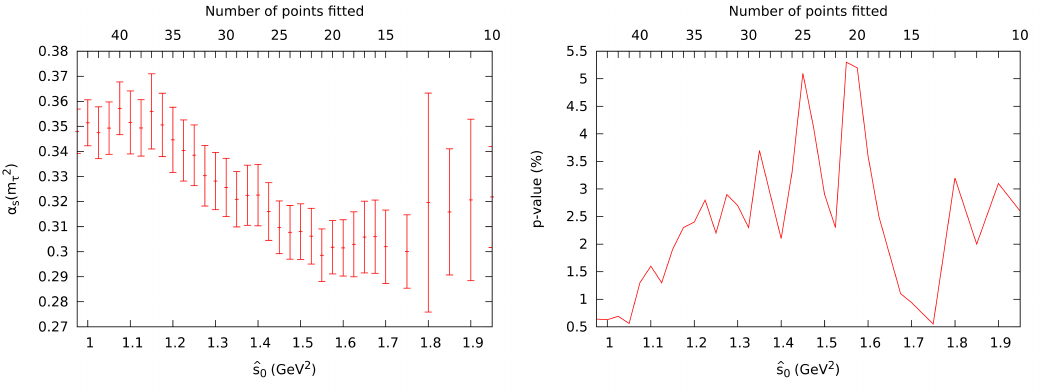
( n = 3 ) ( m 2 ) from the s f τ s